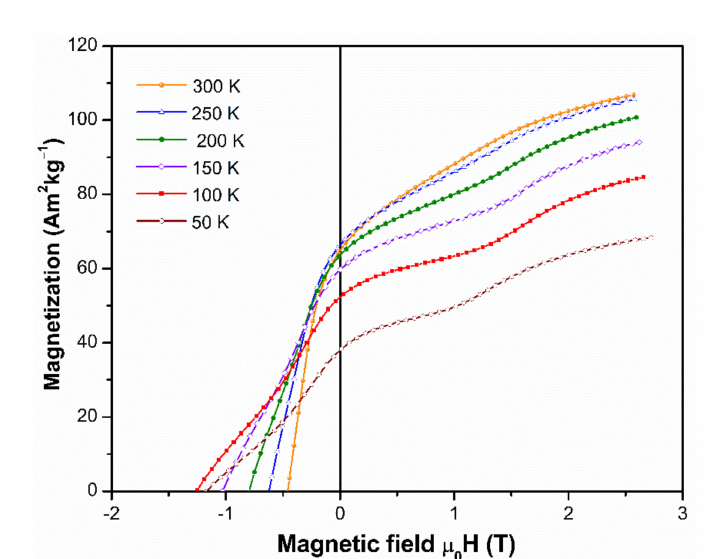
Figure 7. Demagnetization curves of Nd 1.1 Fe 10 CoTiN x powder nitrogenated during 6 h and washed. The specimen was not magnetically